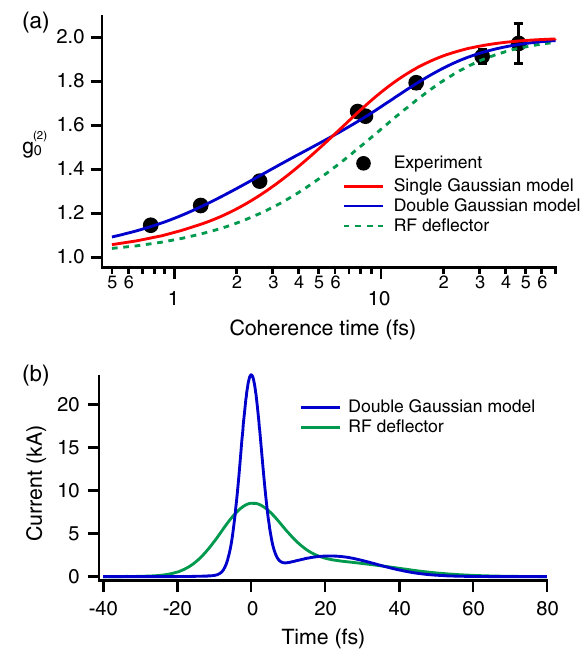
ð 2 Þ FIG. 3. (a) g 0 as a function of coherence time of the x-ray beam after monochromator (black markers) and the fitting results by single (red solid curve) and double (blue solid curve) Gaussian ð 2 Þ function models. Green dotted curve represents g 0 calculated by Eq. (7) with the e-bunch parameters measured by the rf deflector. (b) Current profile of the e-bunch determined by the x-ray HBT interferometry (blue solid curve) and that measured by the rf deflector (green solid curve).